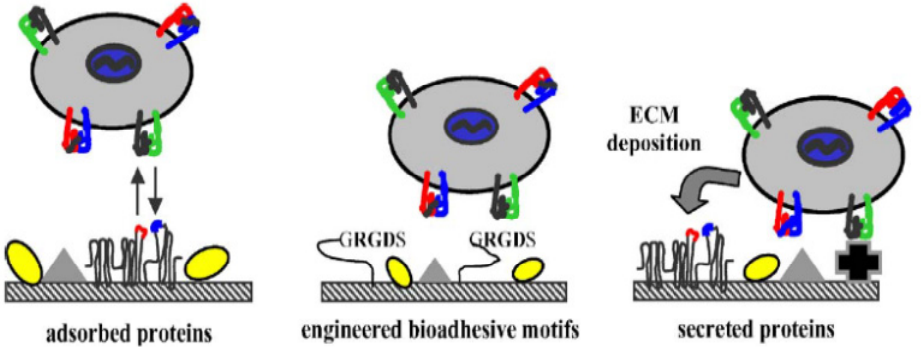
Figure 7. Mechanisms controlling cell adhesion to biomaterials. Reprinted with permission from [58].